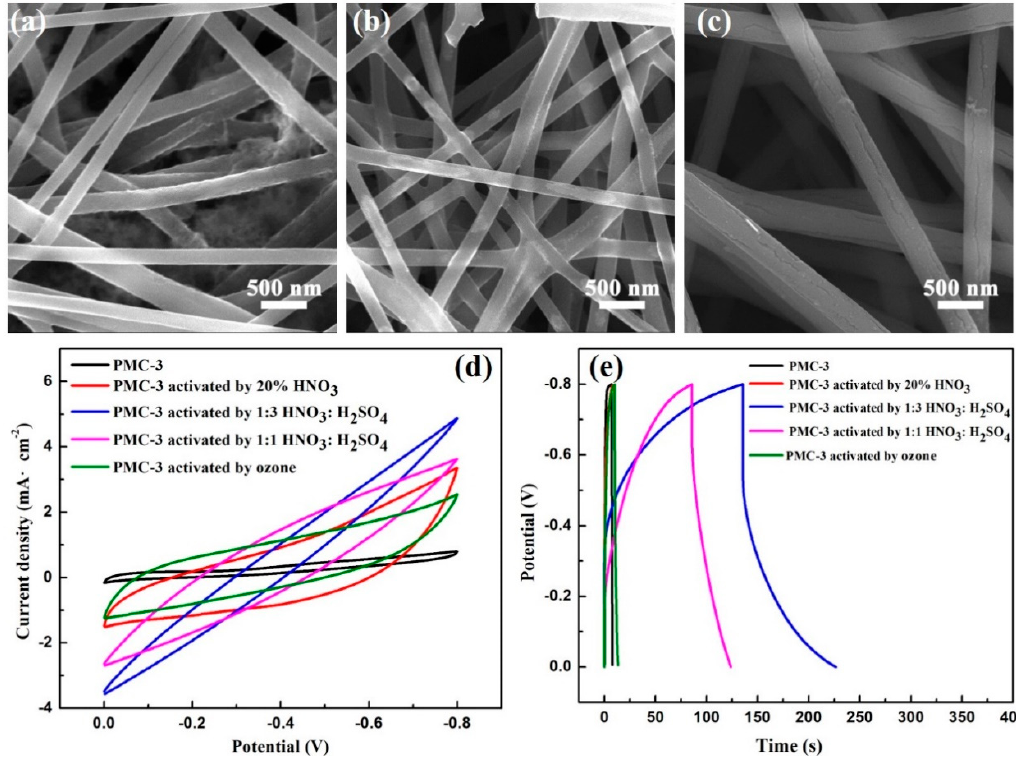
Figure 7. SEM images of the sample PMC-3 activated by 20 wt% HNO 3 ( a ), 1:3 HNO 3 : H 2 SO 4 ( b ) and 1:1 HNO 3 : H 2 SO 4 ( c ), respectively; electrochemical performance comparison of the activated carbon nanofiber mats: ( d ) CV curves at a scan rate of 5 mV/s in potential window of − 0.8~0 V; ( e ) GCD curves at a current density of 0.1 mA/cm 2 .